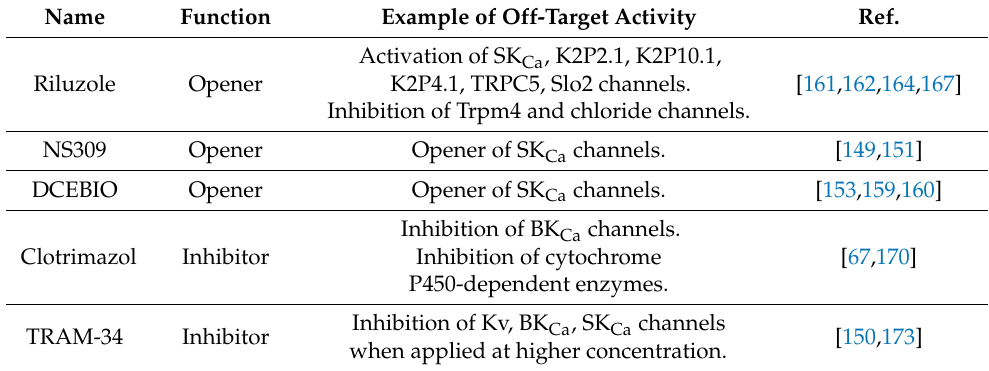
Table 2. Examples of mitoIK channel modulators and their off-target